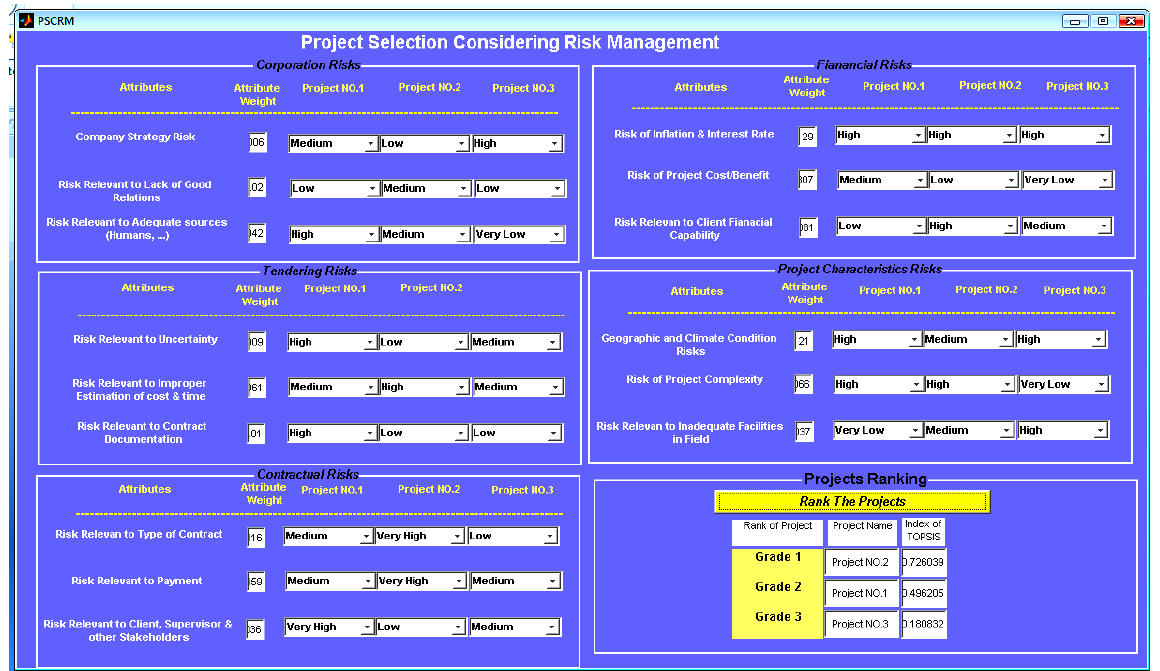
Fig. 4. A view of Project Selection Considering Risk Management (PSCRM)